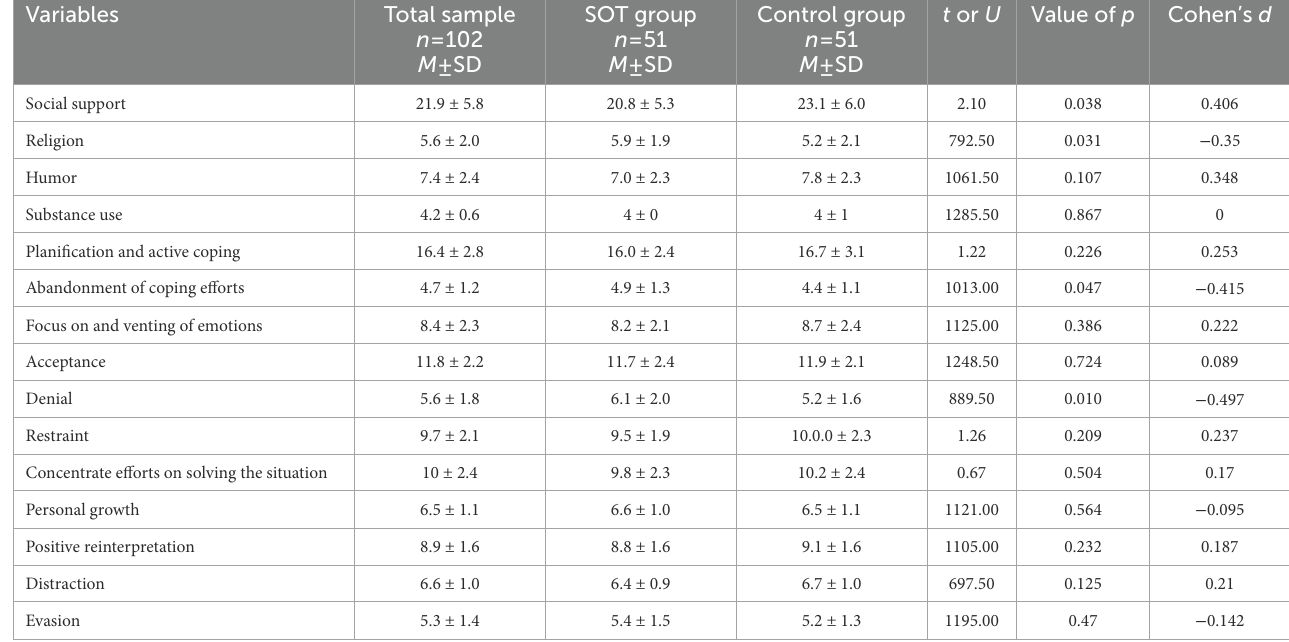
TABLE 4 COPE inventory.